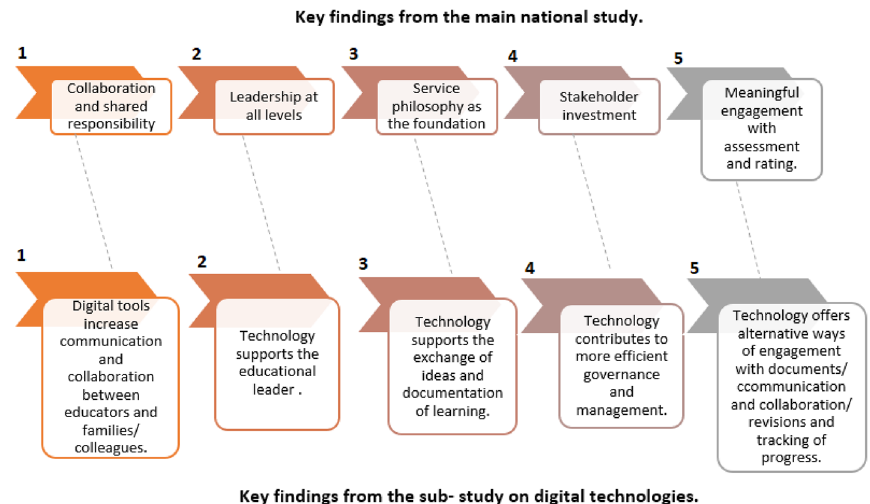
Fig. 2 Aligning findings between the main national study and present sub-study on digital technologies